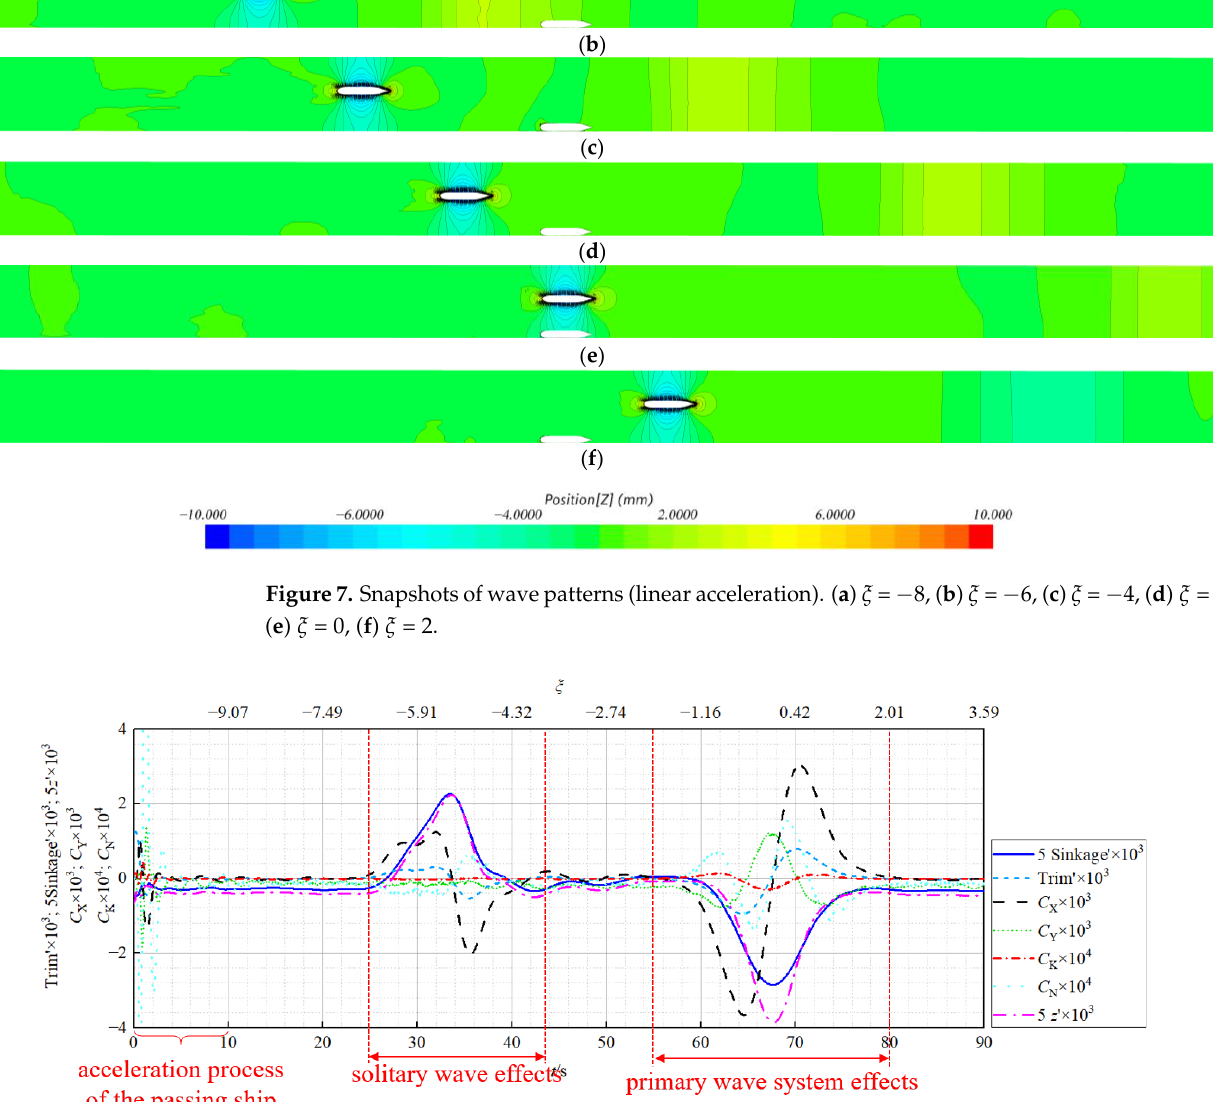
Figure 8. Time histories of the moored ship attitudes, hydrodynamic quantities, and free-surface elevations (linear acceleration).